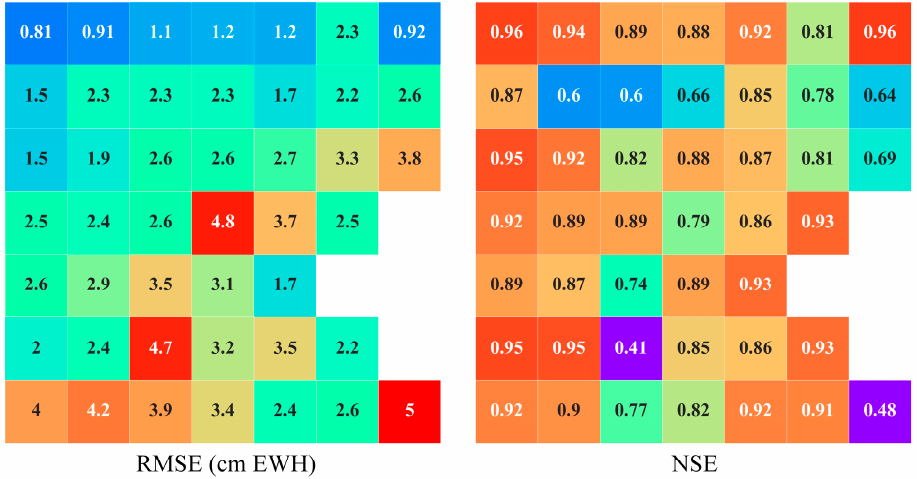
Figure 5. Distribution of RMSEs and NSEs over 45 grid cells for the calibration period.